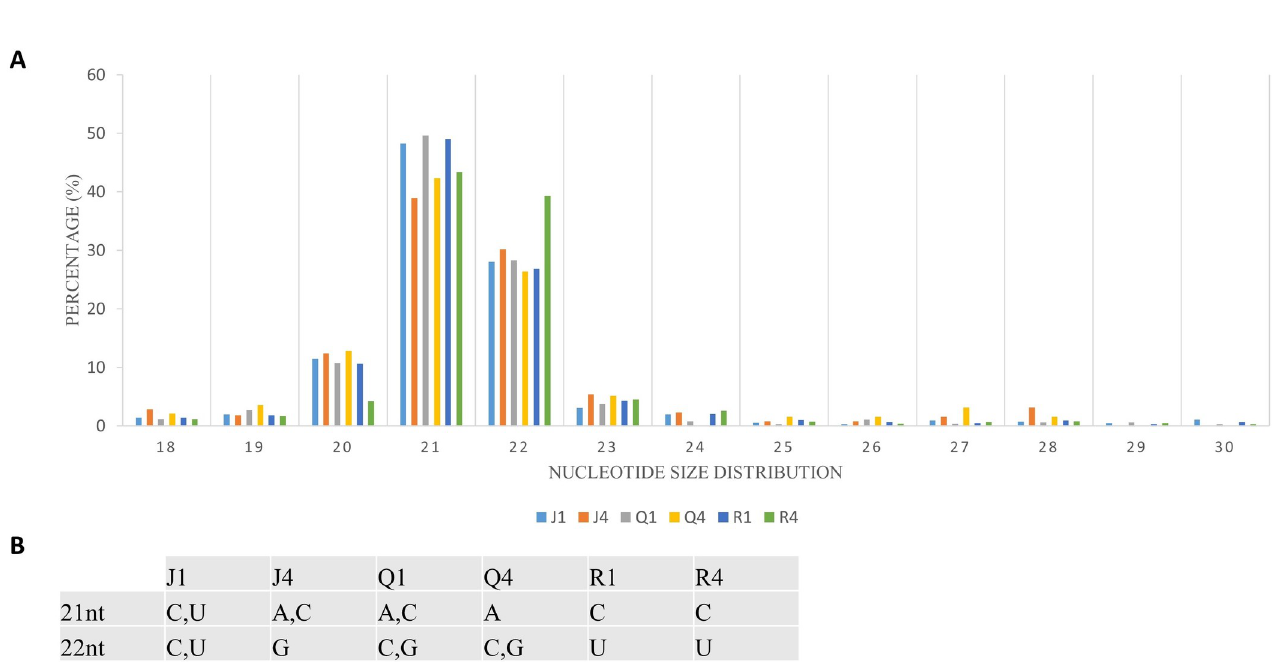
Fig 4. Cucumber mosaic virus (CMV)-derived small interfering RNA (vsiRNA). (A) Nucleotide size distribution of vsiRNA. (B) Enrichment of 5’ terminal base across the varieties and days post inoculation. The graph depicts data from quinoa varieties (J,Q,R), and time (days after inoculation).